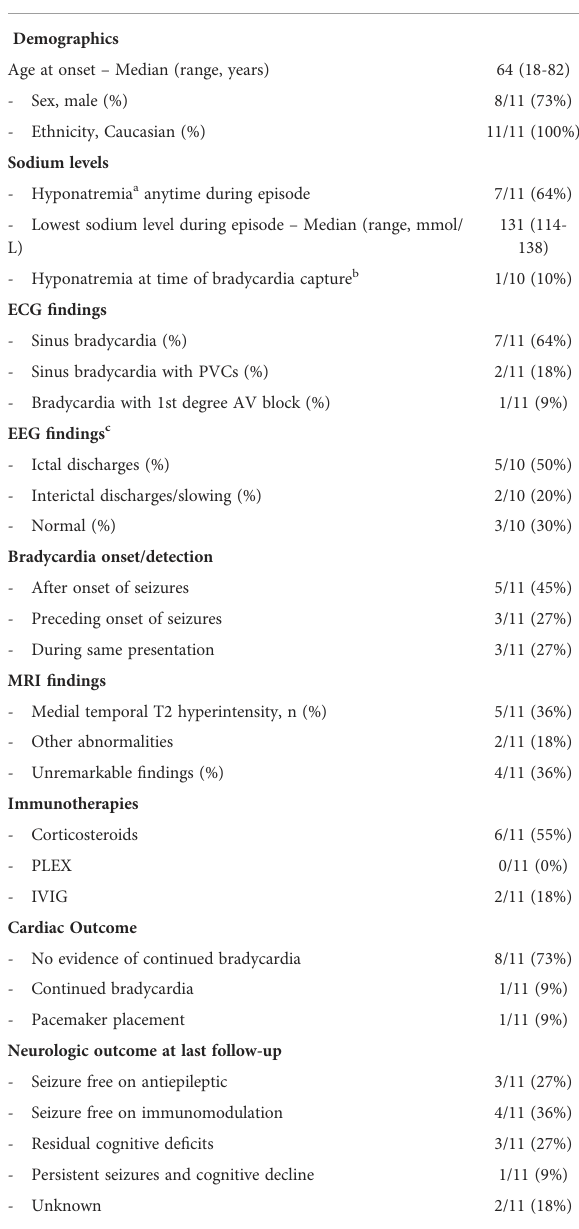
TABLE 1 Demographics, co-morbidities, details of cardiac episode, treatments and outcomes of symptomatic bradycardiac associated with LGI1